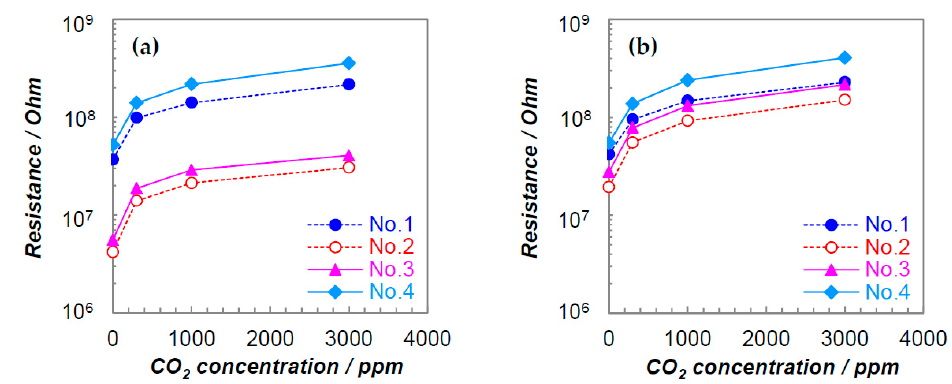
Figure 2. Sensor resistance vs CO 2 concentration for ( a ) initial and ( b ) after